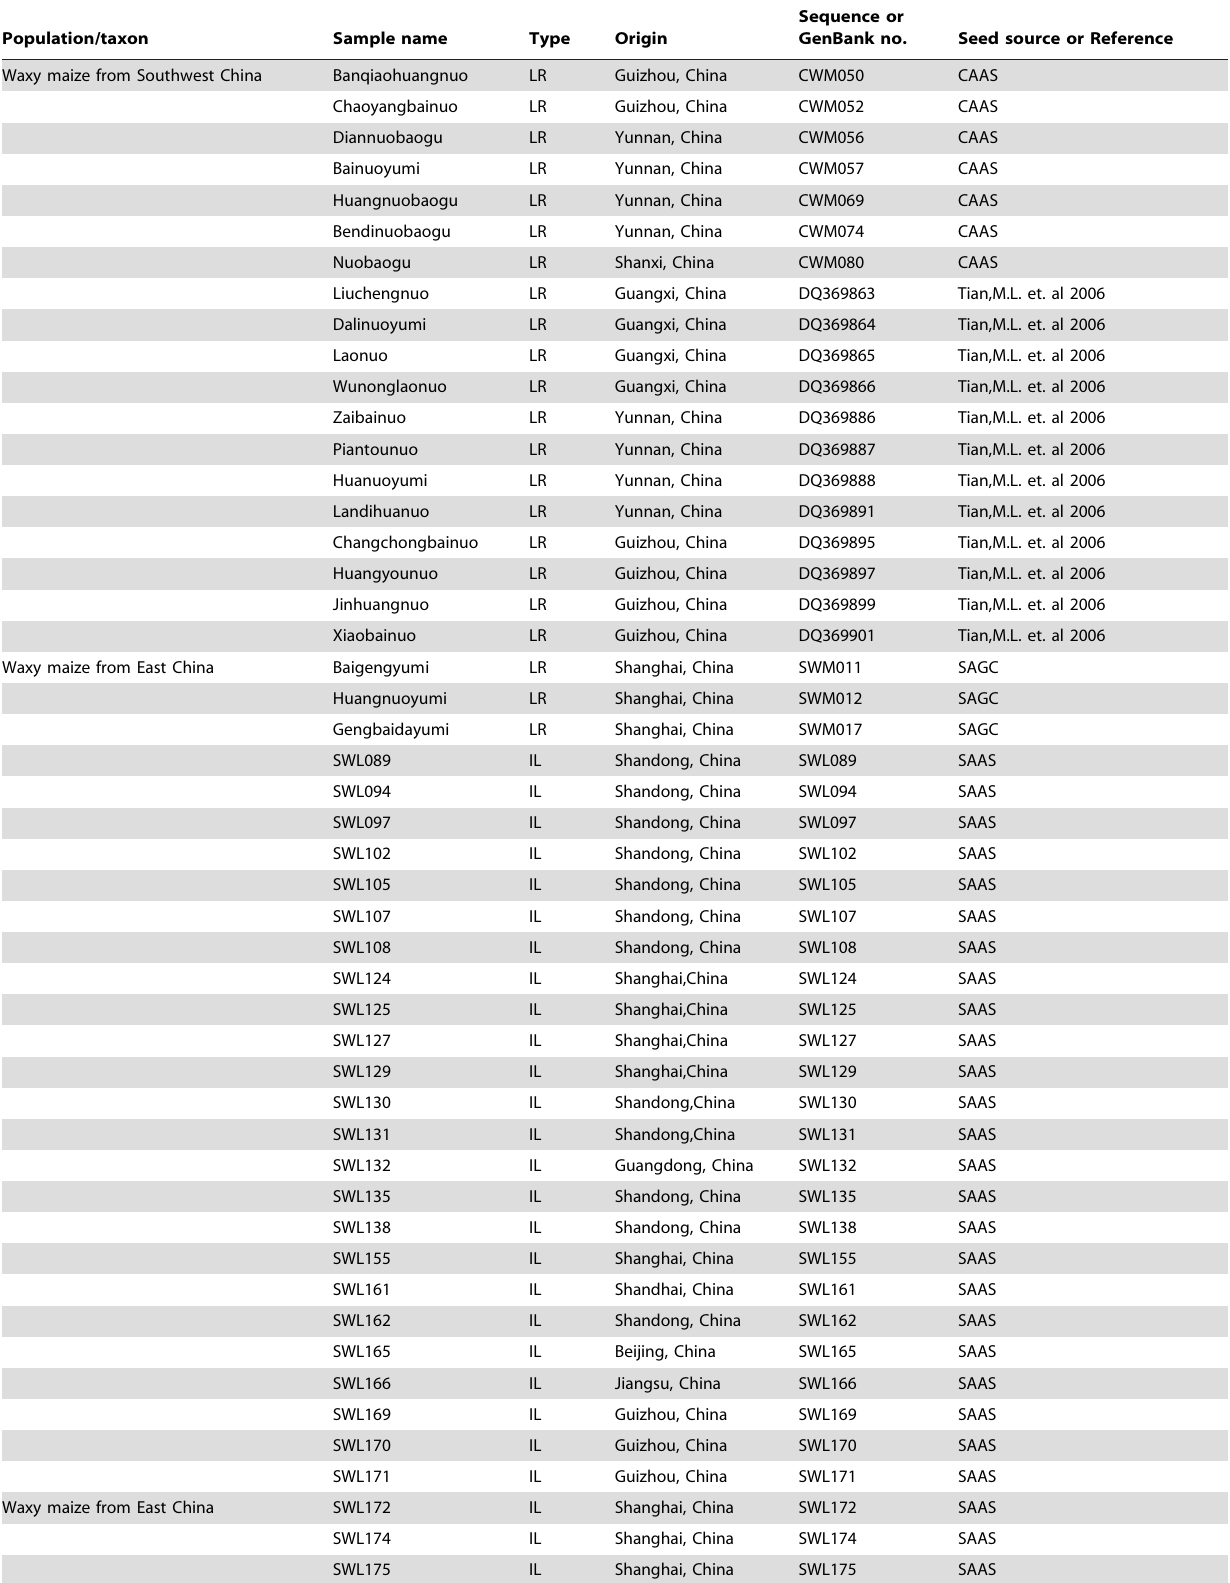
Table 2. Summary of accessions sampled for Waxy gene